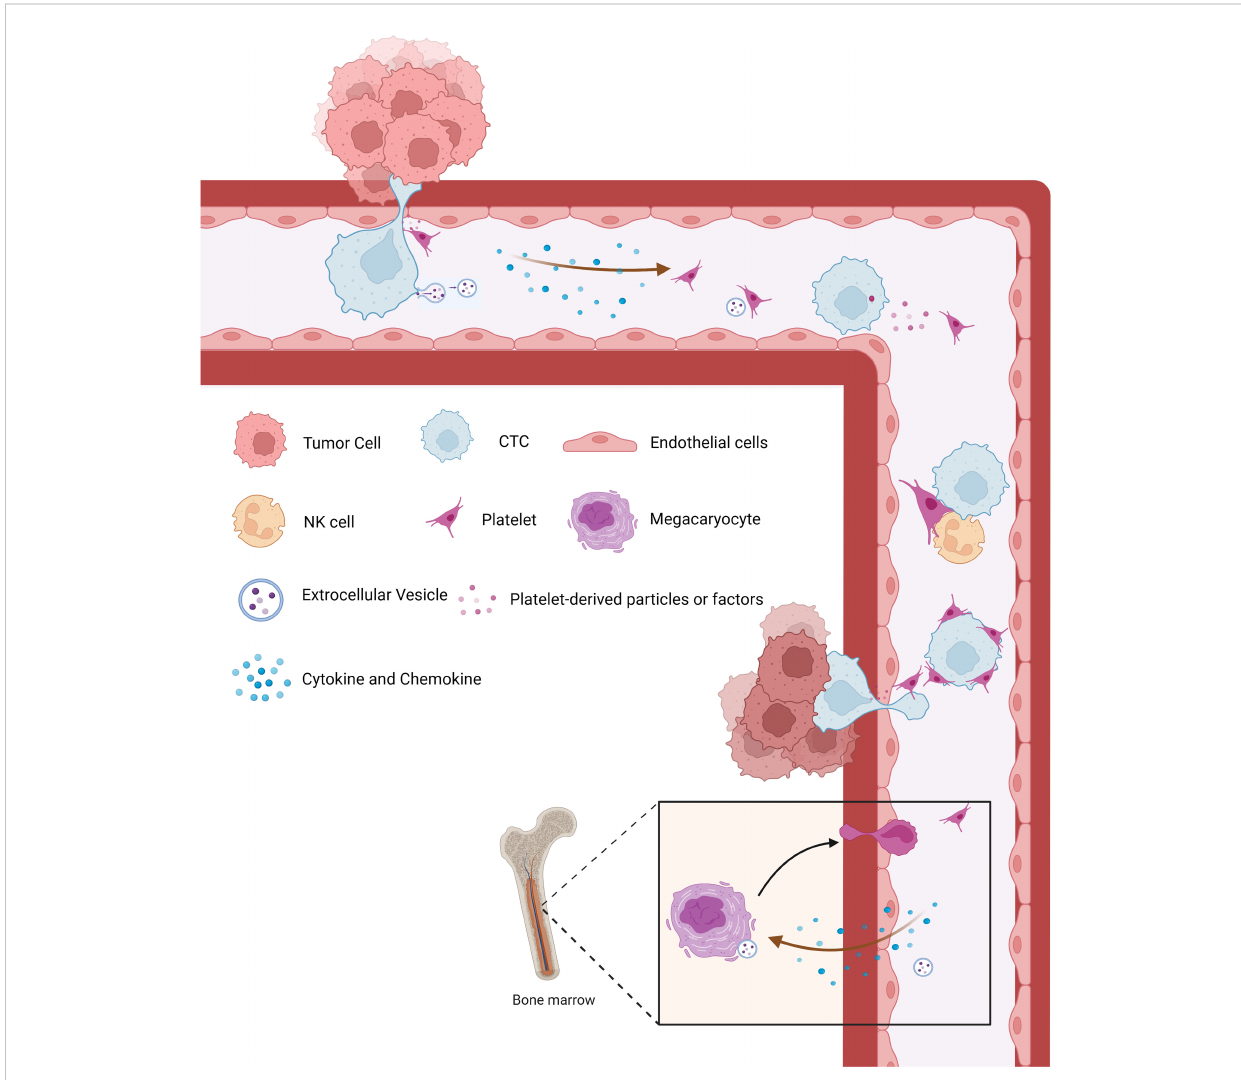
FIGURE 1 The crosstalk between cancer and platelets. Platelets are released into circulation by megakaryocytes and produce tumor-educated platelets through direct or indirect communication with tumor cells or tumor-derived biomolecules. Tumor cells can induce the activation and aggregation of platelets, which in turn secrete various factors that promote the growth and metastasis of the primary tumor. During metastasis, aggregated platelets protect CTCs from shear forces and evade immune surveillance. At the same time, platelets can recruit stromal cells to facilitate the establishment of metastatic niches and promote the metastasis of tumor cells. CTCs, circulating tumor